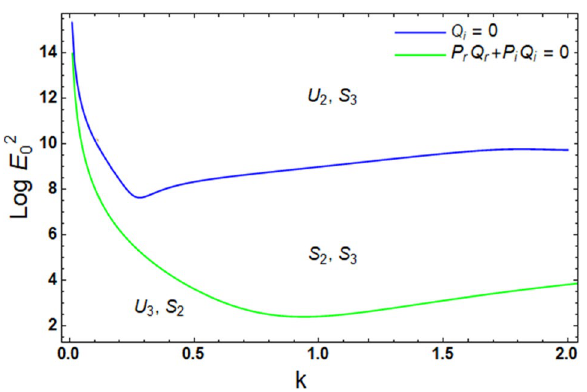
Figure 6. Exhibits the contribution of the two stipulations (62) and